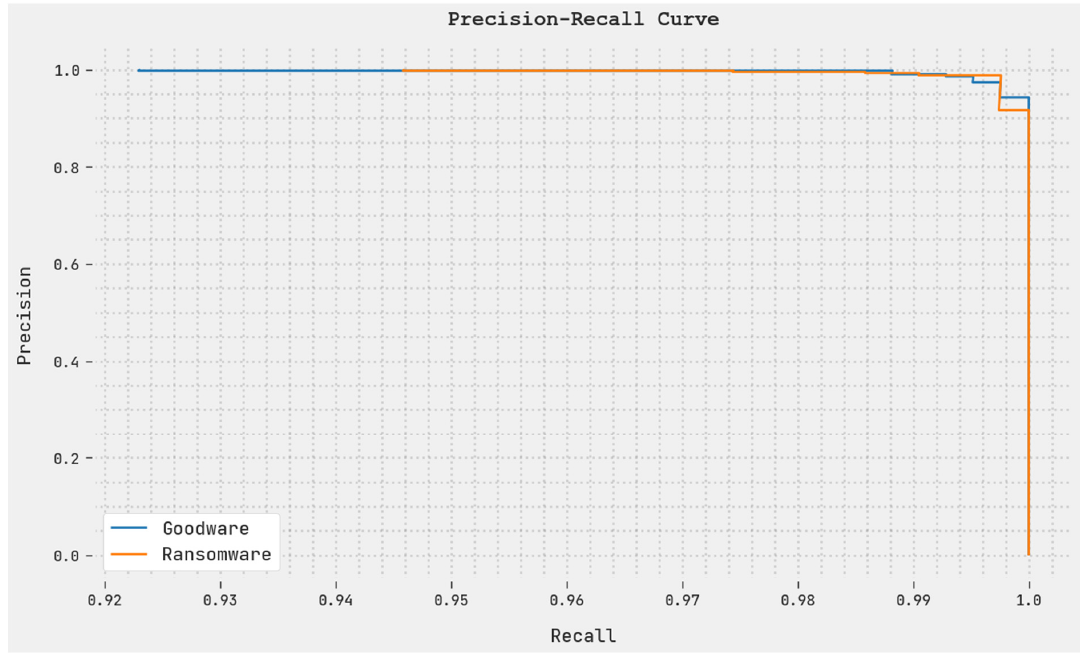
Figure 8. Precision–recall analysis of DWOML-RWD approach.